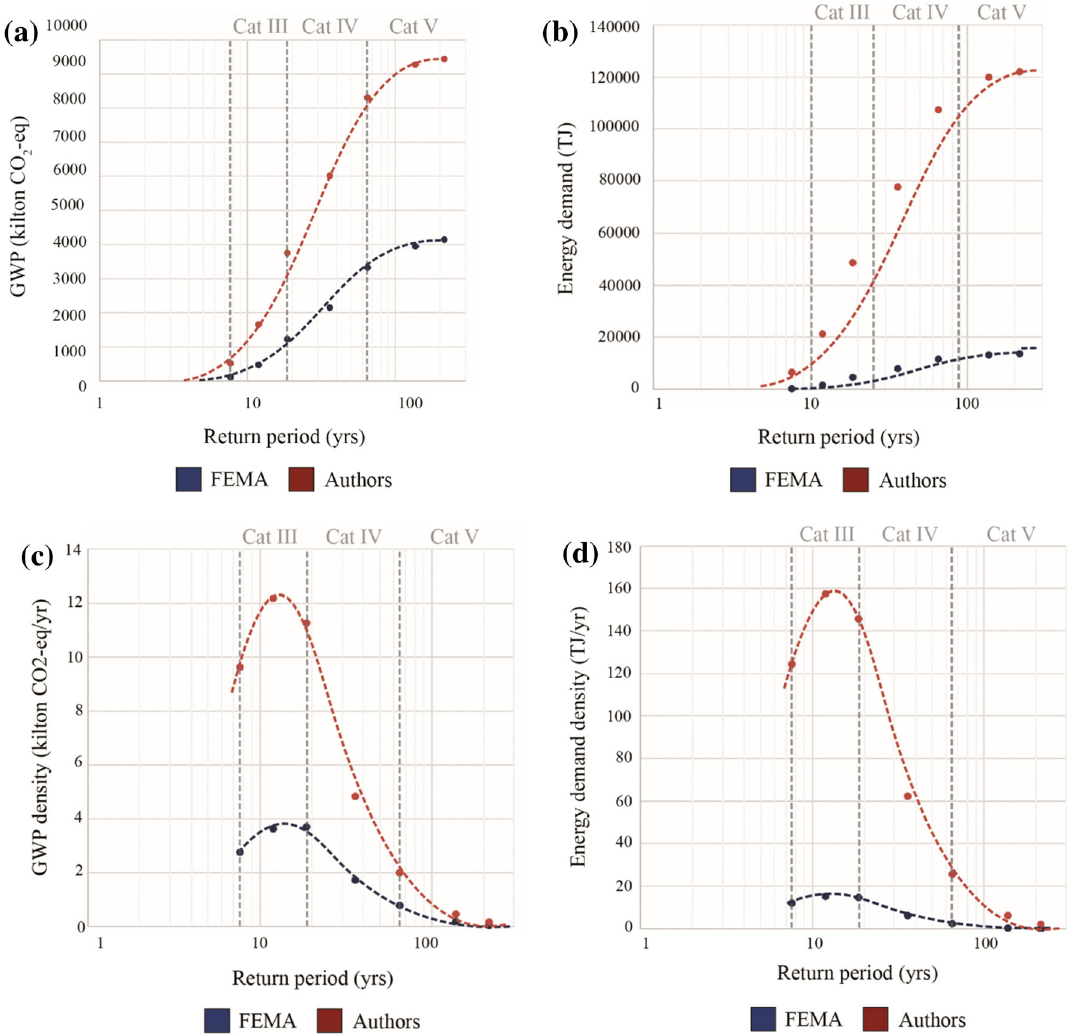
Fig. 4 Impact potential curves ( a , b ) and annual impact density curves ( c , d ) for global warming potential (GWP) and energy demand for intermodal steel building units temporary housing in New Orleans